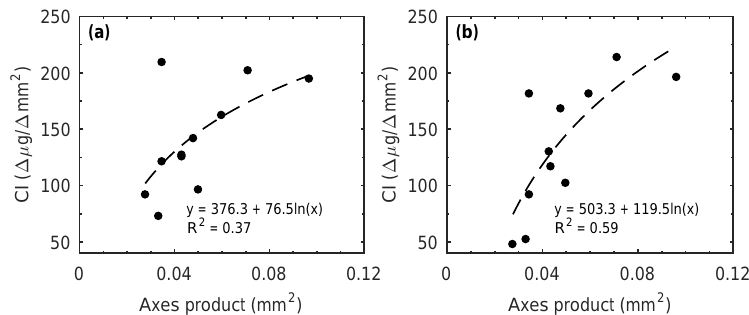
Figure 2. (a) Measured CI as a function of the product of major and minor axes at the start of culture for all experiments. (b) CI data can normalised for the number of chambers added in culture, according to the median CI increase of 17 (cid:49) µg/ (cid:49) mm 2 per chamber added from Fig. 1c, f, i. In this case, data were normalised to two chambers added during culture, which was the mode for our culture